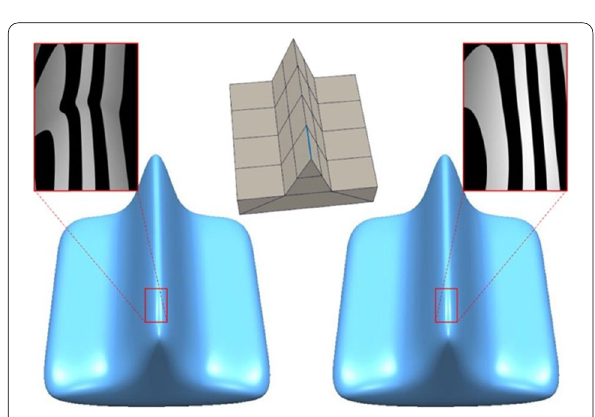
of the EP in each part of the car roof and guitar models. Although the surfaces obtained using the method in ref. [7] and the proposed approach are both G 1 , the improved surfaces of the latter are smoother. A complex model was also tested in which the knot intervals of the adja- cent edges of the EP were significantly different, as shown on the right side of Fig. 12. In the selected space